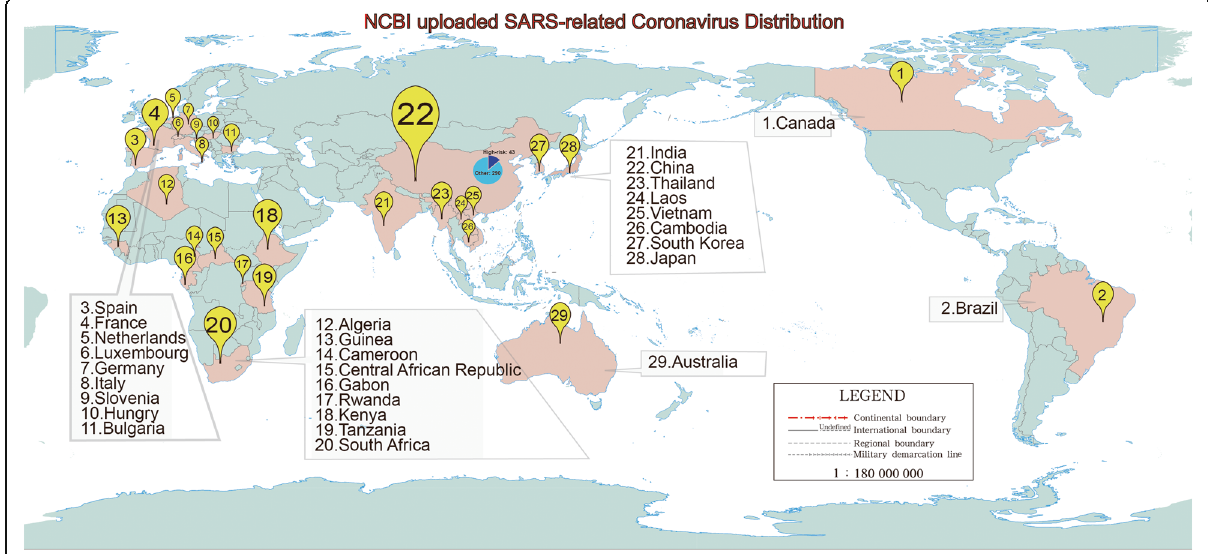
Fig. 1 Geographical distribution of bat SARSr-CoVs (censor code of this map: S (2016) 1666). High-risk sequences, determined by a higher sequence similarity than WIV1 or RaTG13 to their respective reference sequences (SARS-CoV-1 or SARS-CoV-2). A conserved around 400 bp viral RdRp sequences were used for